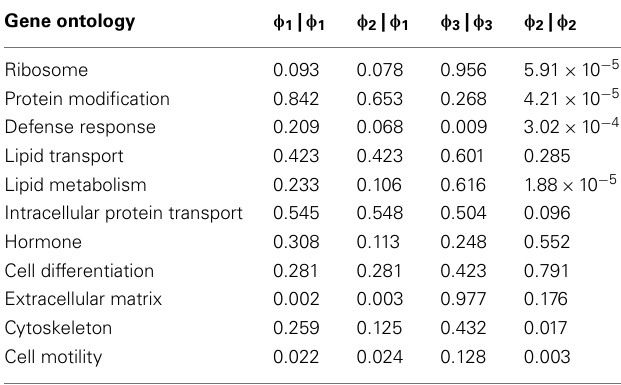
Table 3 | Comparison of methods on the Girotti and Zingg (2003) data.